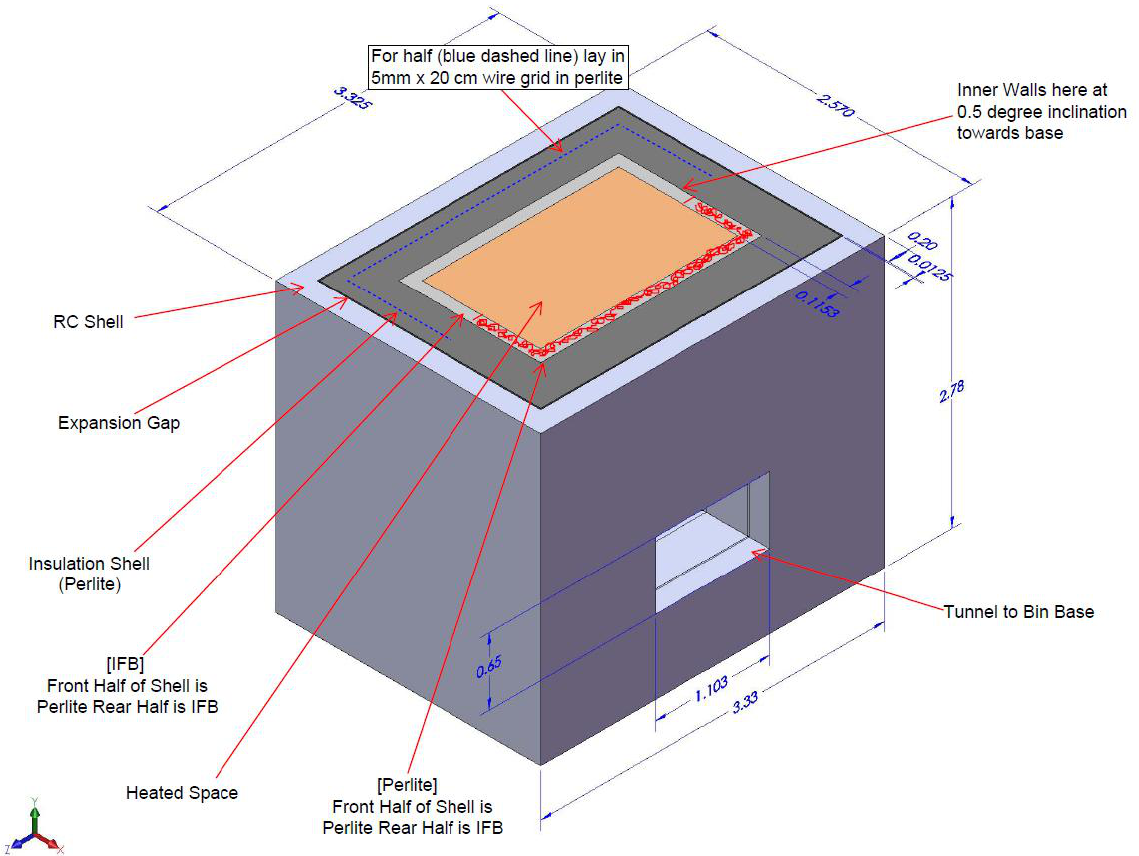
Figure 7. Scaled thermal energy storage (TES) bin for the heat loss measurements and the materials testing (all dimensions are in